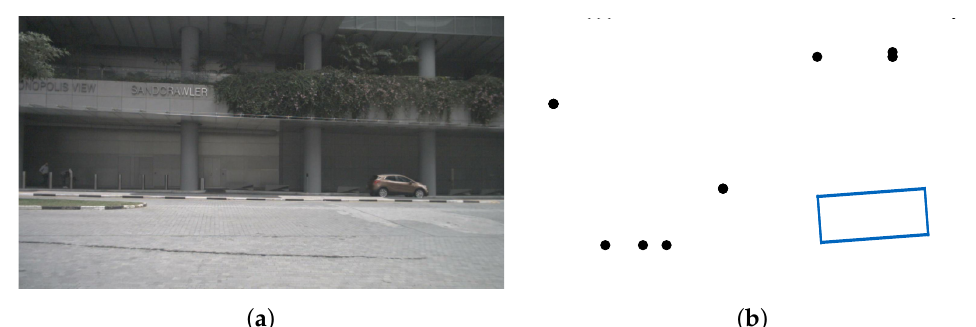
Figure 12. Vehicle in line-of-sight direction from the radar sensor. Despite its exposed position, it is not detected with the sensor settings used. ( a ) The vehicle in camera view in front of the sensor vehicle. ( b ) BEV: Zoom onto the GT bounding box in blue and the radar data in the surroundings. No radar return originates from the vehicle. NuScenes sample token: bbba31d91e334f4abf6d1f96bf699980.